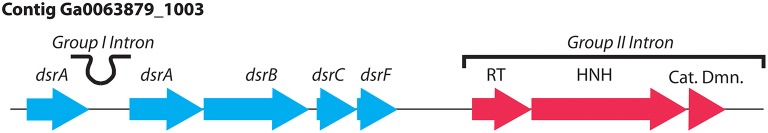
Oxidative dissimilatory sulfite reductase operon with a group I intron interrupting the dsrA gene and a group II intron containing accessory genes that facilitate the intron's insertion into the genome.